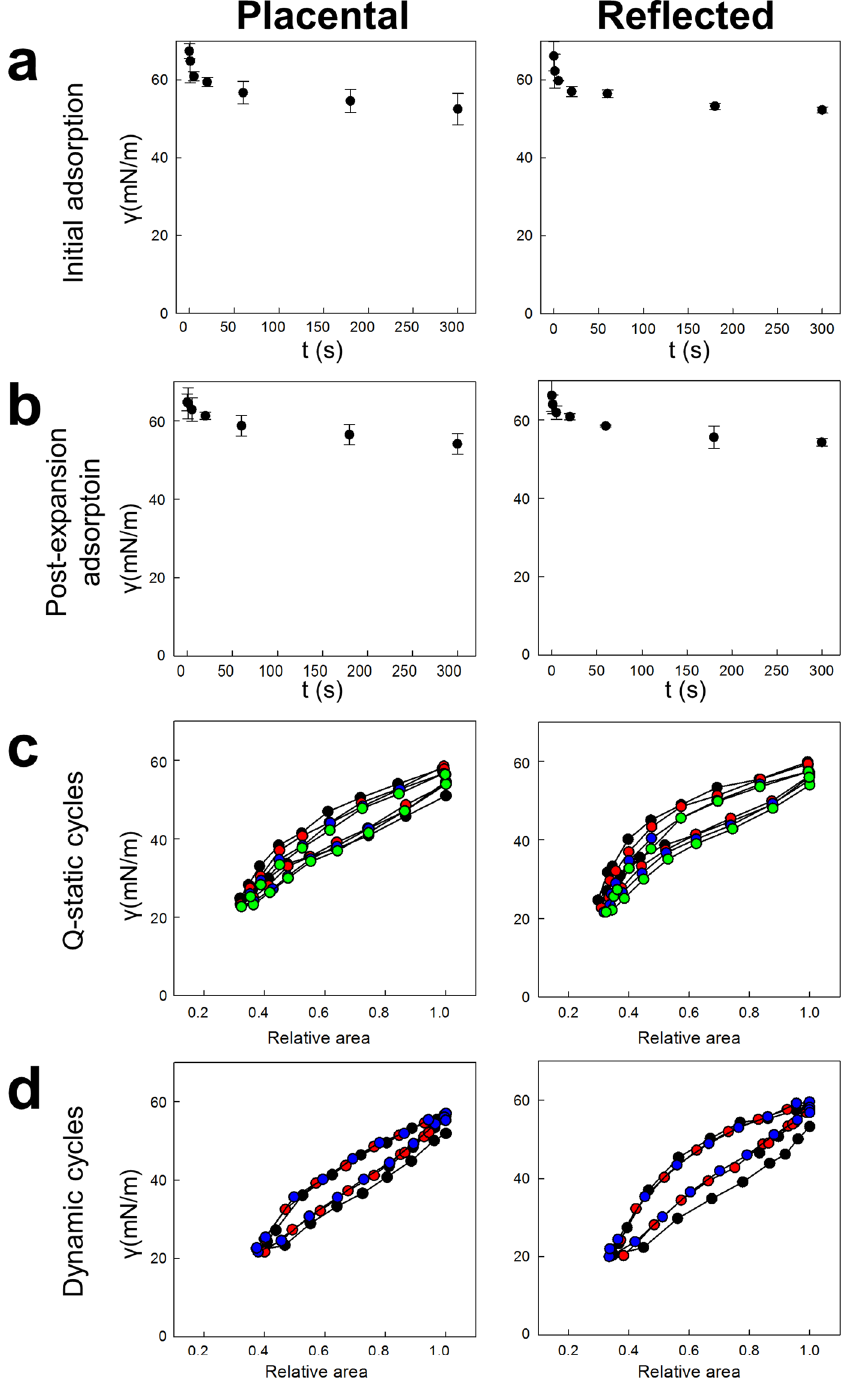
Figure 7. Biophysical behaviour of hAM supernatant tested using Captive Bubble Surfactometry. ( a ) Initial adsorption, ( b ) post-expansion adsorption and isotherms obtained during ( c ) slow (quasistatic) and ( d ) fast (dynamic) compression-expansion cycling of aqueous suspensions of PS-like material isolated from supernatants of placental and reflected hAM explants. Initial and post-expansion adsorptions are represented as average of three replicates. A representative replicate of three experiments is typified for quasistatic and dynamic cycles. All quasistatic cycles are illustrated (first in black, second in red, third in blue and fourth in green). Only first (black), tenth (red) and twentieth (blue) cycles are shown for dynamic